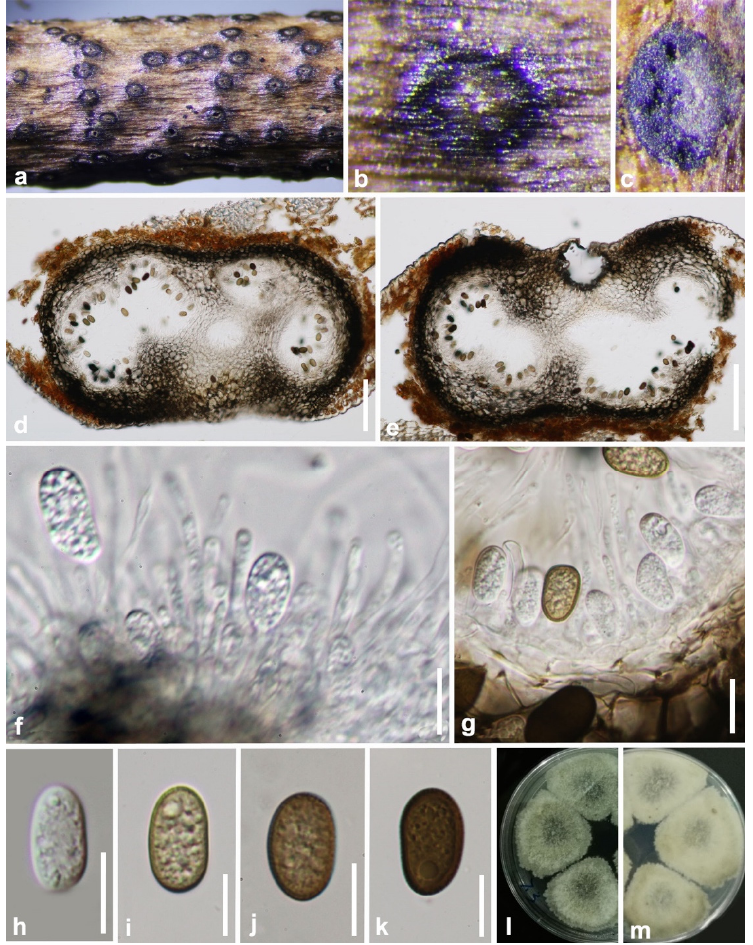
Figure 2. Aplosporella hesperidica (GZAAS 19-1814). ( a – c ) Conidiomata on host surface. ( d , e ) Ver- tical hand sections of multiloculate conidiomata. ( f , g ) Developing conidia attached to conidioge- nous cells. ( h ) Hyaline immature conidium. ( i – k ) Mature brown conidia. ( l , m ) Five-day-old culture on PDA (OXOID CM0139) from above and below. Scale bars: ( d , e ) = 100 µm, ( f – k ) = 10 µm. Barriopsis tectonae Doilom, L.A. Shuttlew., and K.D. Hyde, Phytotaxa 176: 84 (2014) (Figure